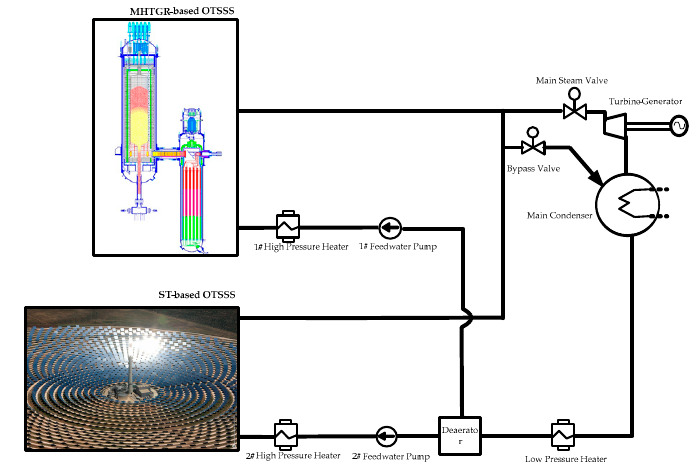
Figure 6. A nuclear-solar hybrid energy system (HES) constituted by an MHTGR-based and a solar power tower STP-based OTSSSs.